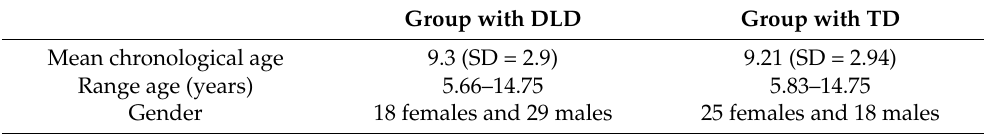
Table 1. Characteristics of the sample. Group with DLD Group with